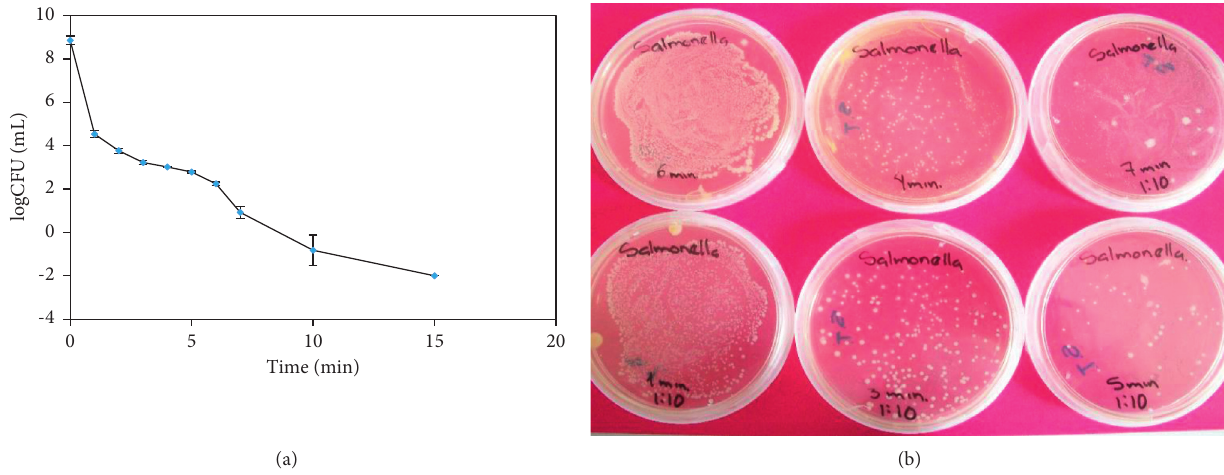
Figure 2: Biomass reduction. (a) Death kinetics of Salmonella ATCC13076; (b) Salmonella ATCC13076 cell in Petri dishes.